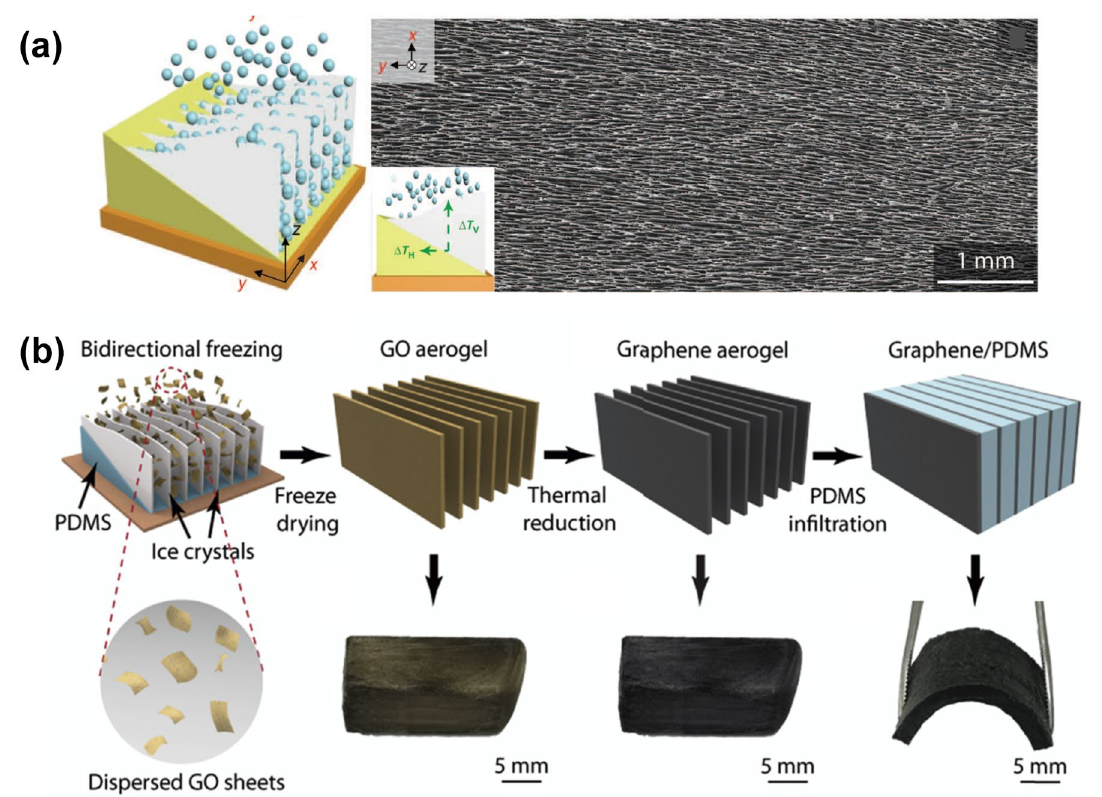
Fig. 11 Schemes of bidirectional freezing techniques and resulting scaffolds [198,